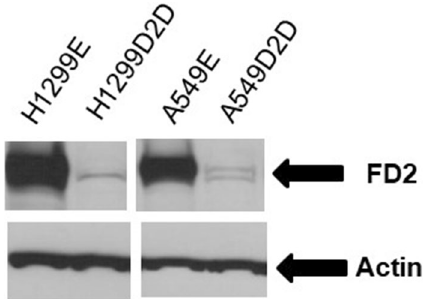
Figure 2. Western blot analysis of FANCD2 protein expression. Non-small cell lung cancer cells H1299 and A549 were transduced with FANCD2-specific shRNA-expressing or empty vector and puromycin-resistant lentiviral particles. The transduced cells were selected in 4 ug/ml puromycin to create stably transduced cells with reduced FANCD2 expression, the H1299D2D and A549D2D. H1299E and A549E were transduced with empty lentiviral particles. FANCD2 protein expression was confirmed by western blot